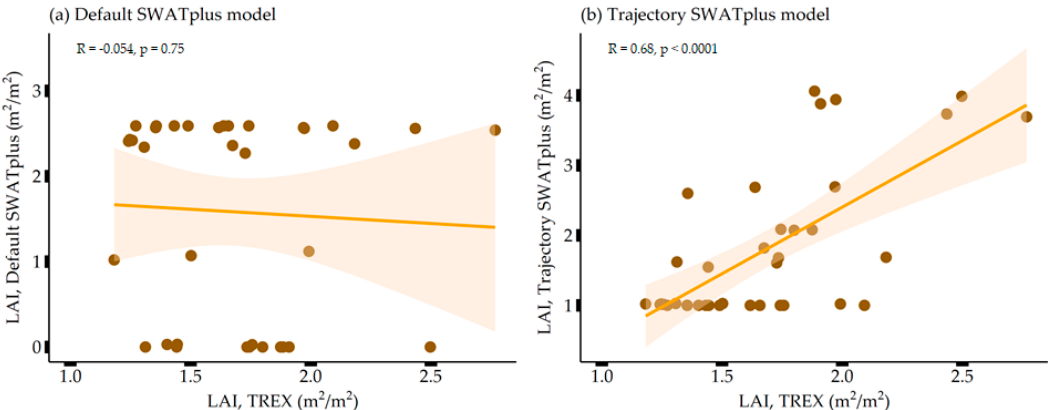
Figure 8. Correlation analysis between TREX LAI and SWAT+ default models and irrigated banana, coffee, and maize to irrigated banana and coffee to irrigated banana, coffee, and maize trajectory outputs.